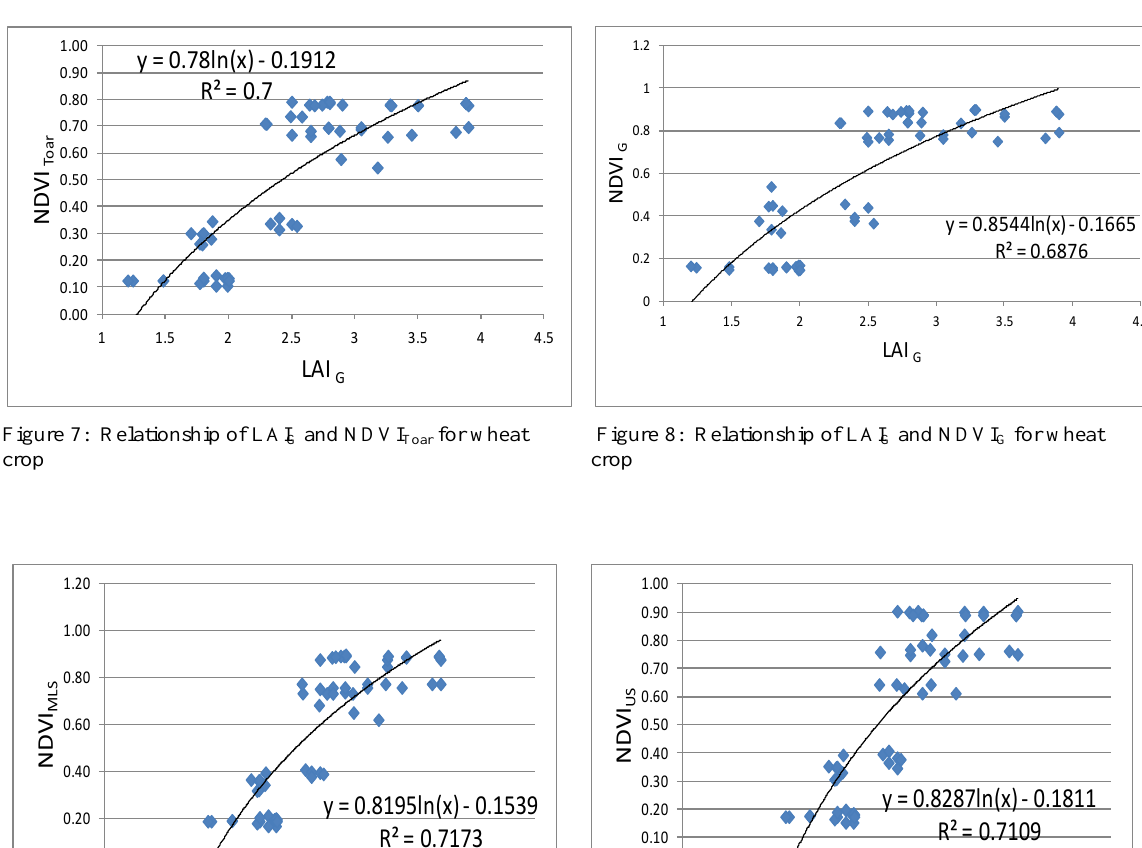
y = 0.78ln(x) - 0.1912 R² =